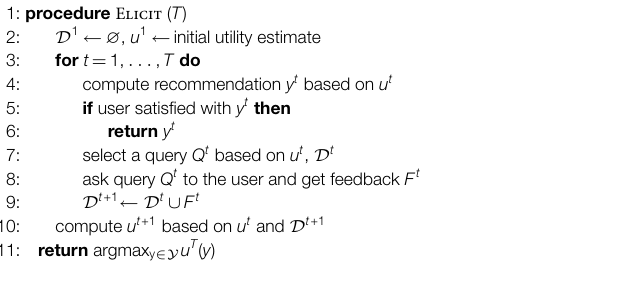
Algorithm 1 | Template algorithm for preference